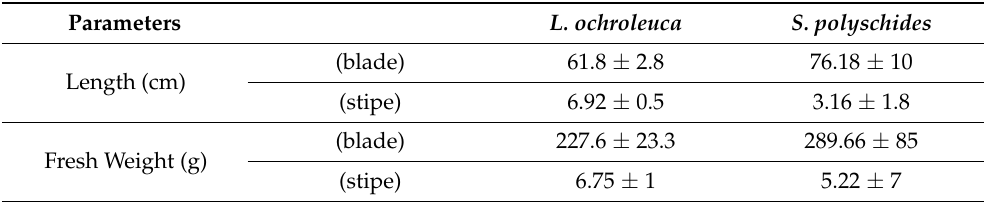
Table 1. Characteristics of L. ochroleuca and S. polyschides during May 2018.